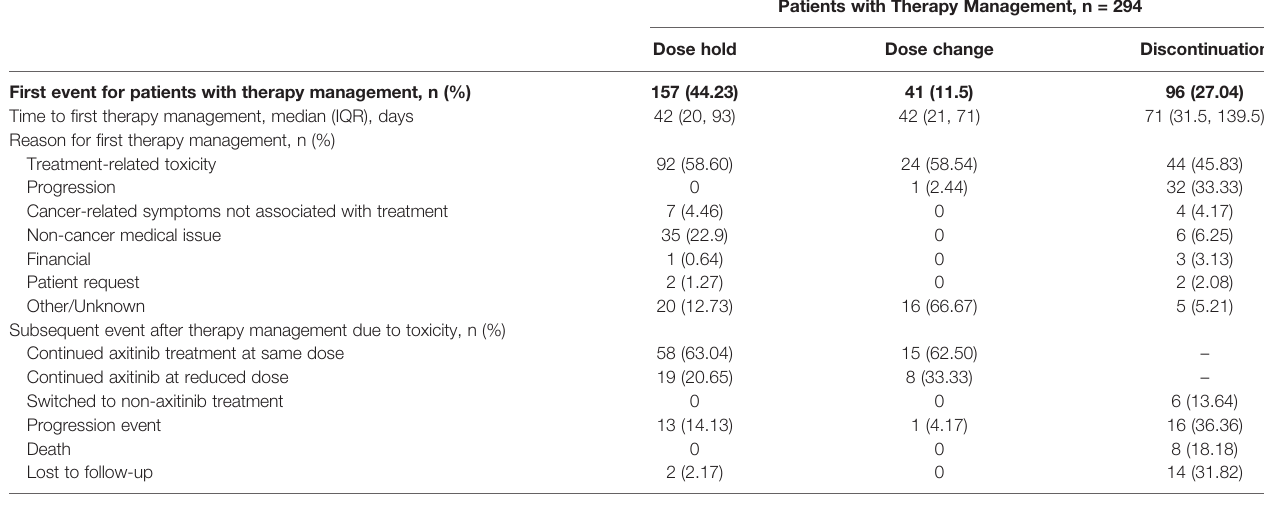
TABLE 4 | First therapy management and subsequent events after therapy management due to toxicity.